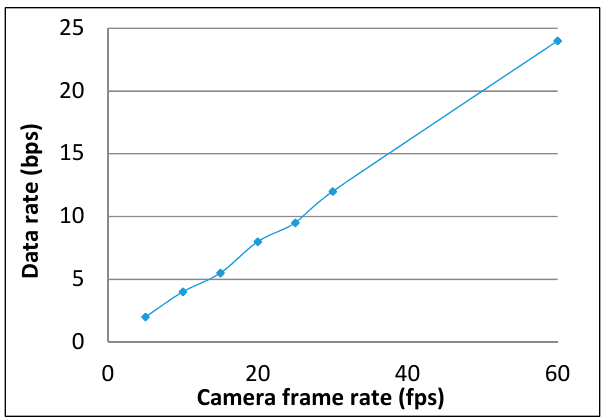
Figure 20. Data rate performance of 2FSOOK.